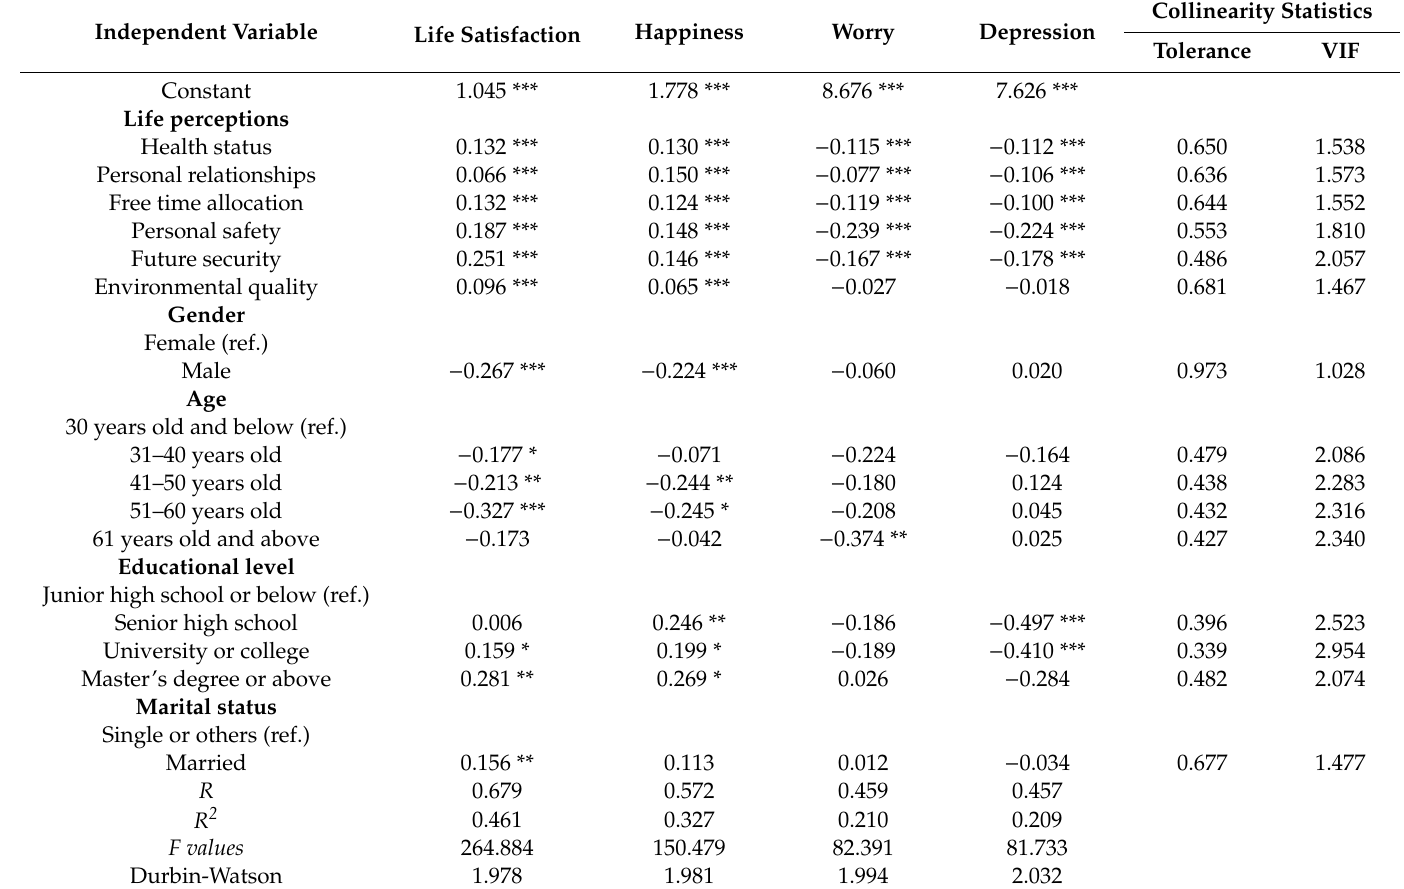
Table 4. Ordinary least squares (OLS) estimation of regression model (dependent variable: emotional